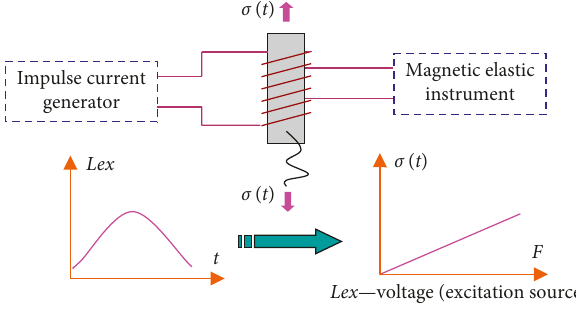
Figure 3: Measuring